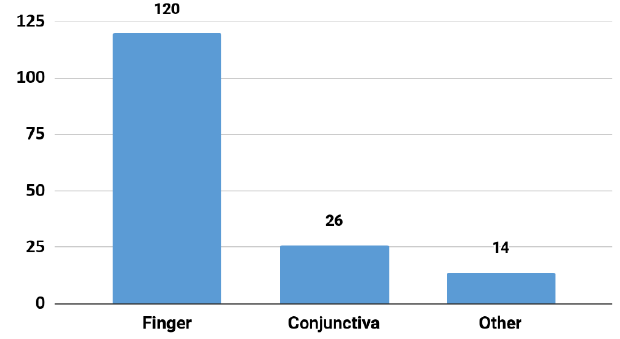
Figure 7. Region of the body investigated in published papers.